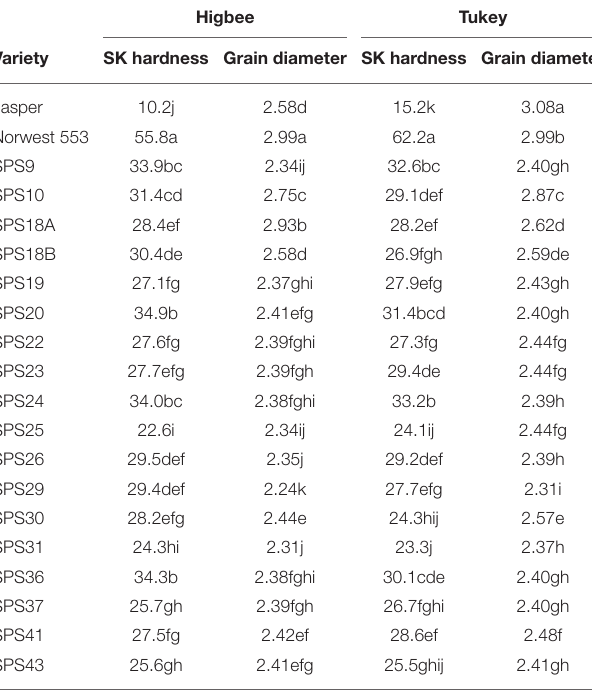
TABLE 12 | Protein (%), starch (%), ash (%), crude fiber (%), and neutral detergent fiber (NDF, %) at the Higbee location. Variety Protein Starch Ash Fiber